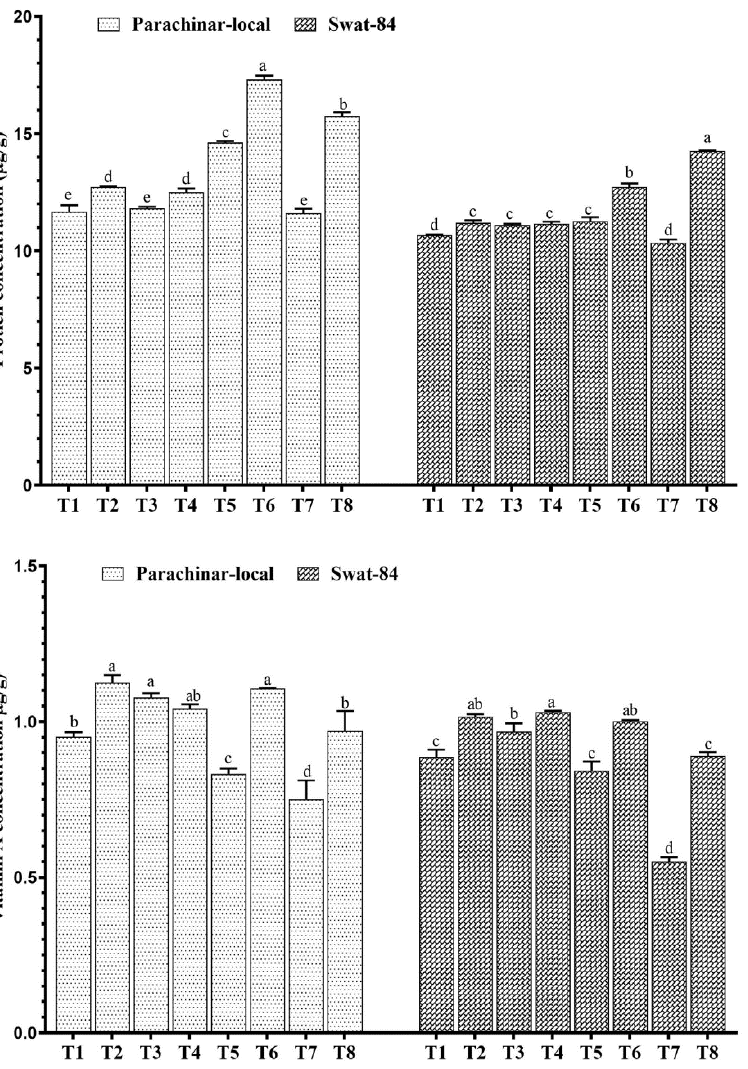
Figure 3. Changes in protein and vitamin A concentration under salt stress and exogenous JA application. Different letters for each column for each variety show significantly different values at p < 0.05 according to Duncan’s method. T1 (Control), T2 (Control + JA), T3 (40 mM), T4 (40 mM + JA), T5 (80 mM), T6 (80 mM + JA), T7 (120 mM), T8 (120 mM + JA).